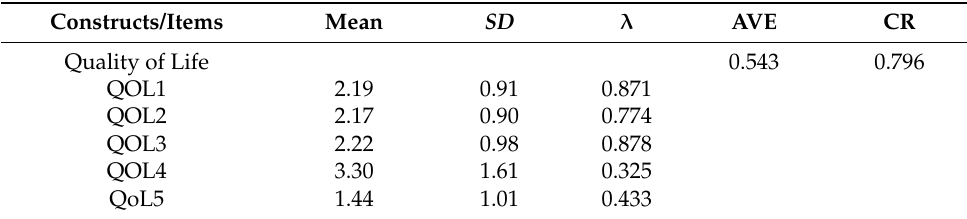
Table 5. Factor loading, convergent reliability, and convergent validity of the confirmatory factor analysis for the quality of life domain ( n =